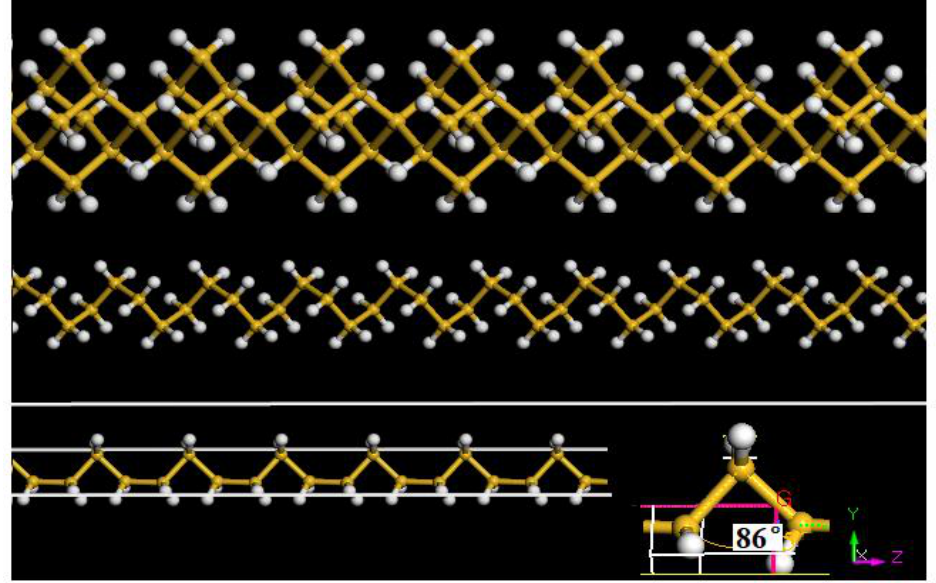
Figure 5. Change curve of bandgap energy with various diameter of Si NW, in which the black curve describes the simulating result and the red curve is fit one.